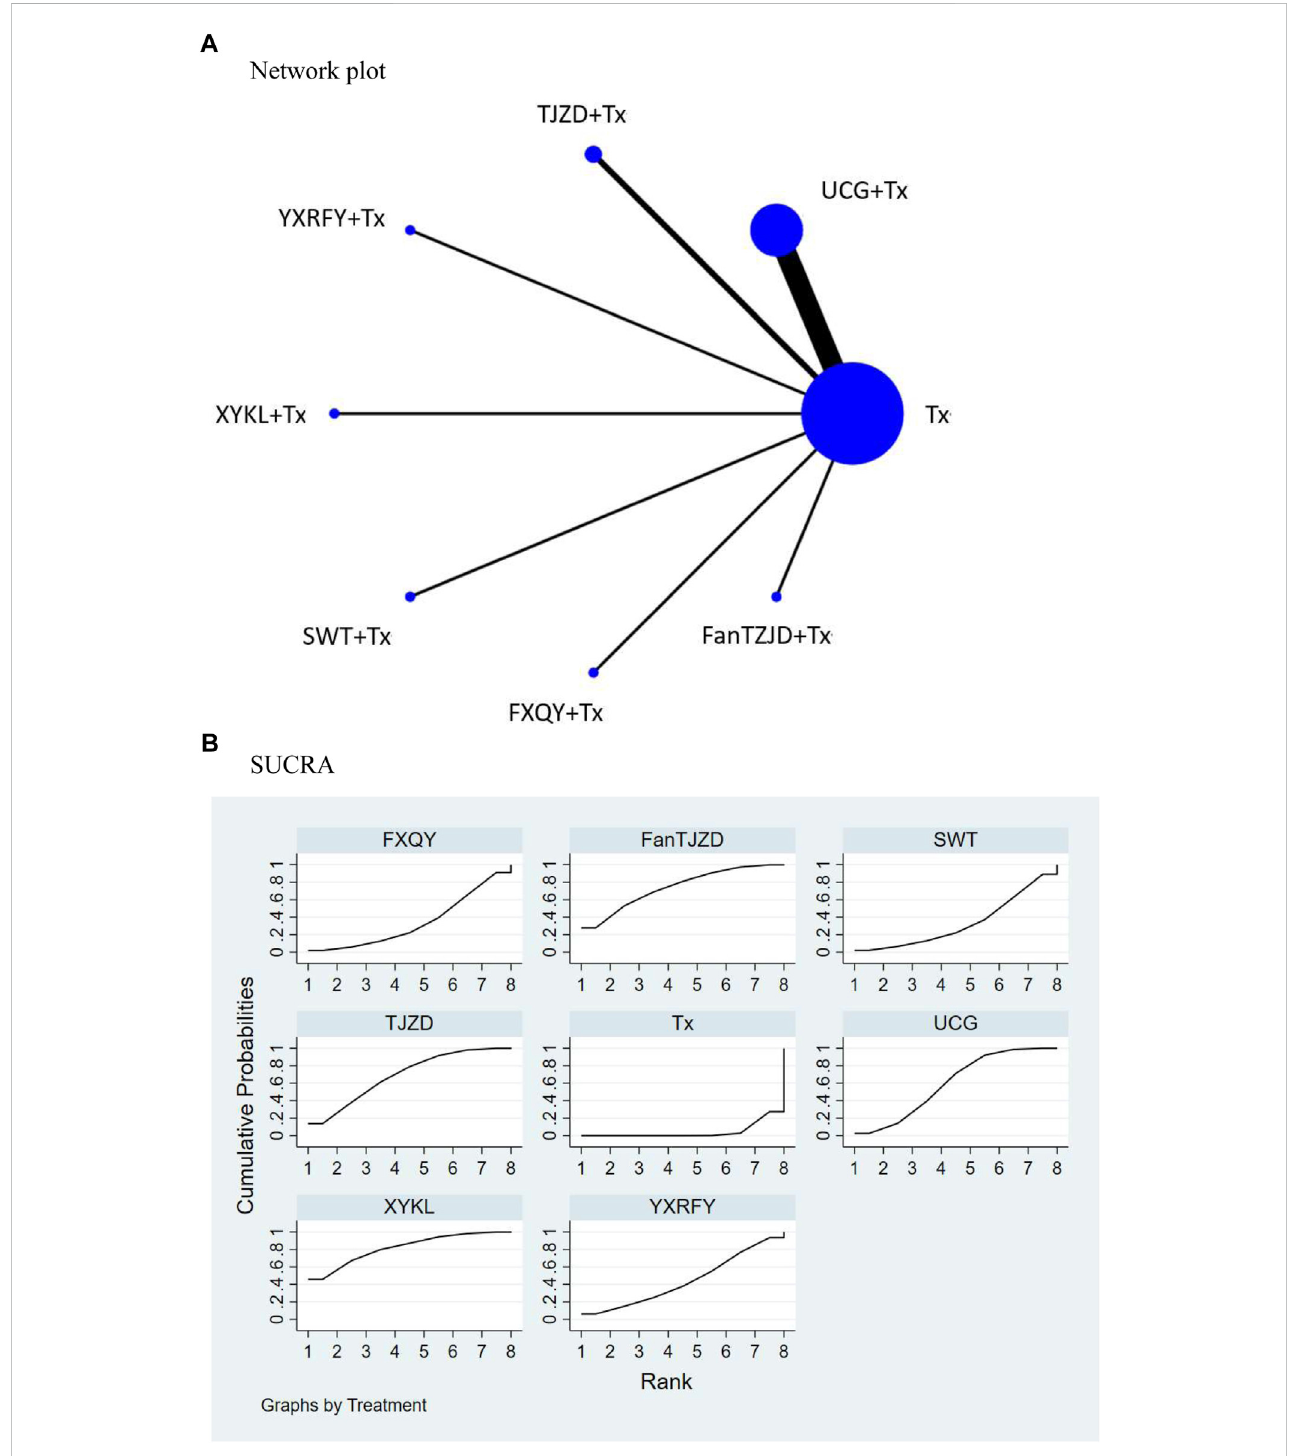
FIGURE 2 Results of network meta-analysis for the visual analog scale (VAS). (A) Network plot: Each node corresponds to one treatment, node size is proportional to the number of subjects, and line thickness is proportional to the number of randomized controlled trials providing comparison data. (B) SUCRA: Surface under the cumulative ranking curve. SUCRA determines the overall ranking of each treatment. A larger area under the curve corresponds to a higher ranking. Higher ranking indicates a better treatment in the network meta-analysis. Abbreviations: FanTJZD, Fan ’ s Touxie Jiedu Zhiyang Decoction; FXQY, Feng Xueqing Yin; SWT , Siwu Tang; TJZD , Touxie Jiedu Zhiyang Decoction; Tx , Conventional treatment; UCG , Uremic Clearance Granules; XYKL , Xiaoyang Ke Li; YXRFY , Yangxue Runfu